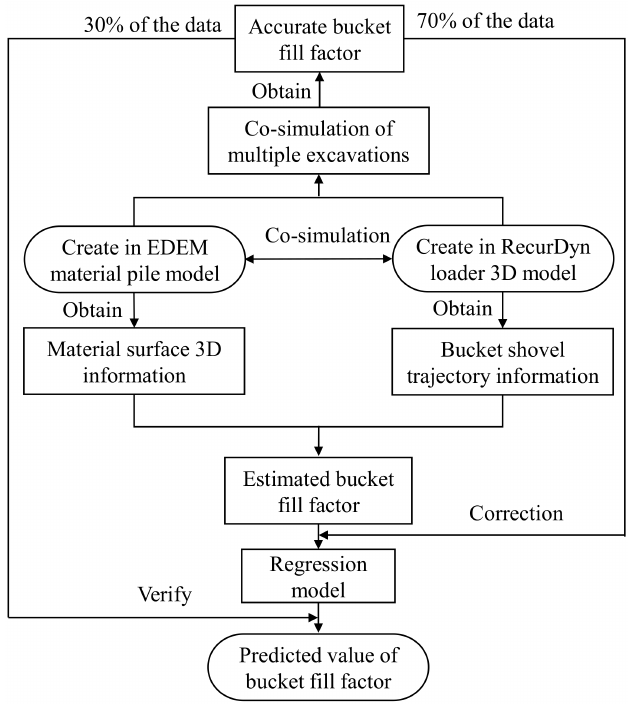
Figure 1. Flow chart of prediction method of bucket fill